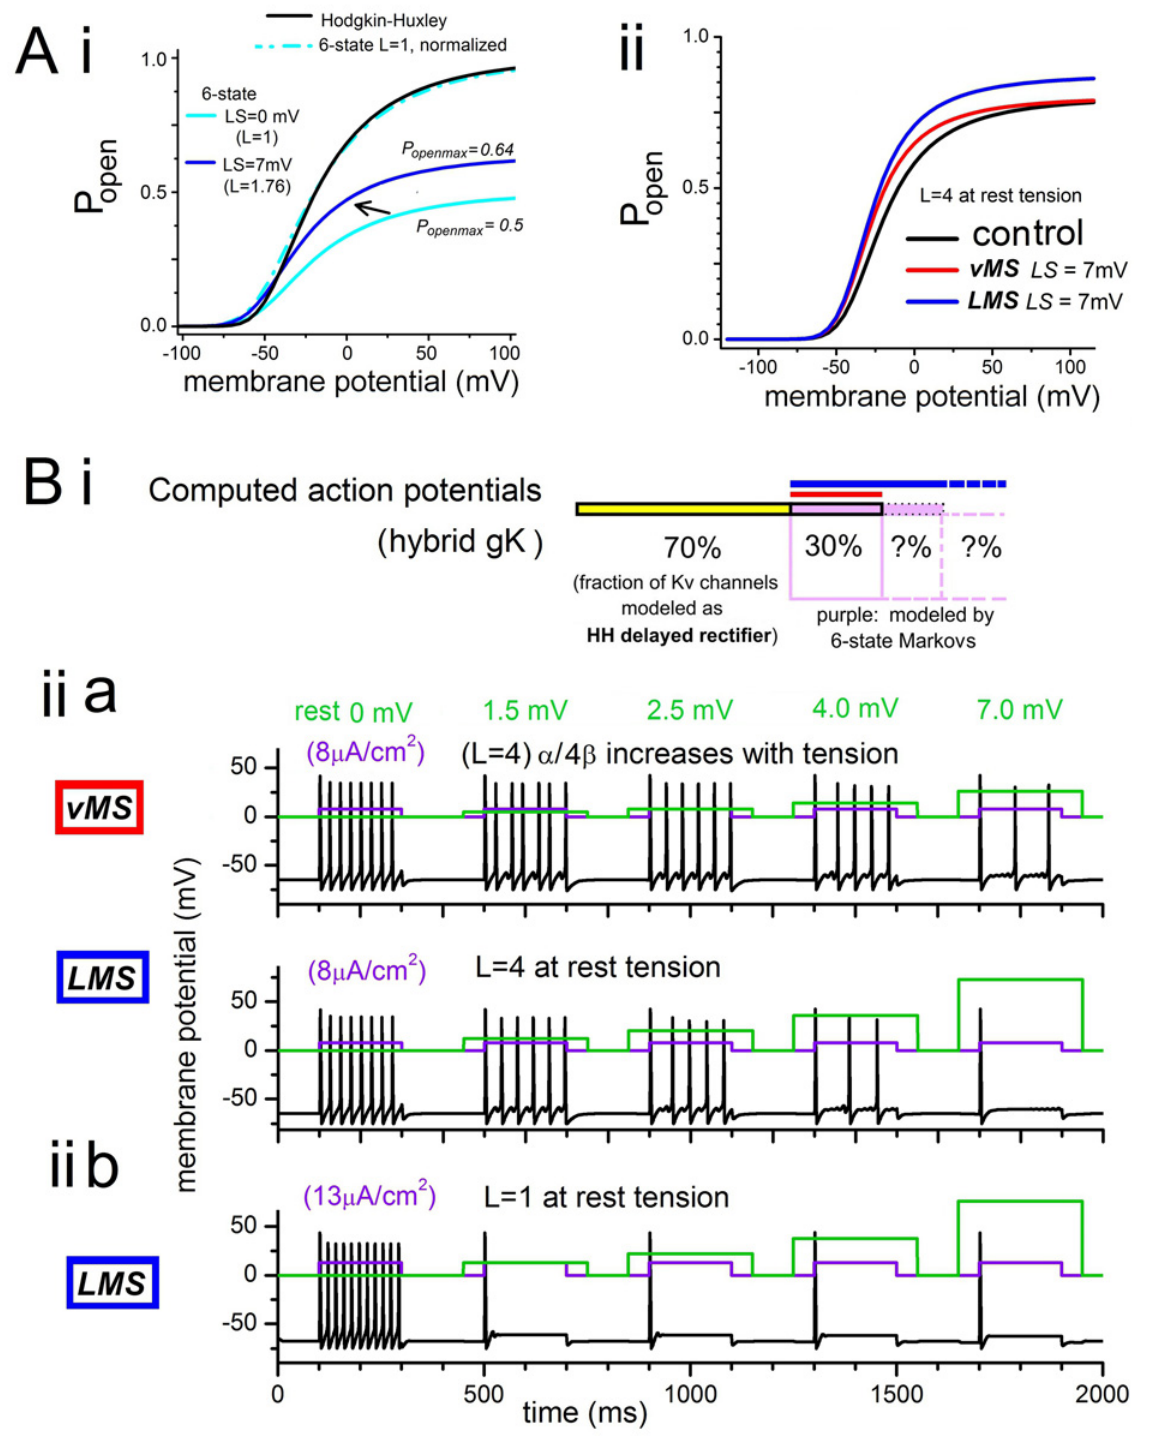
Fig 8. Effects of stretch-modulated MS Kv (3 versions) on electrically stimulated APs. In these excitability models, 70% of gK max is a Hodgkin-Huxley (HH) type gK and the remaining 30% is a Scheme 1 (6-state) Markov adjusted to approximate the HH-type gK with respect to V 0 . 5 and steepness (see Table 3 for the parameter values). Ai . Normalized P open (V) s for HH and 6-state systems with L = 1.0 (rest), plus non-normalized plots for L = 1.0 and L = 1.76 (i.e., 7 mV of LMS left shift). Aii . For the 6-state Markov using L = 4 as rest value, P open (V) for that rest value and for a 7 mV left-shift ( LMS : L changes from $ C α /4 β changes by a factor of 1.76). Bi . Diagram of contributions to gK “ pre-stressed rest ” of 4.0 to 6.9; vMS : the ratio of C 4 5 kinetic constants max (two